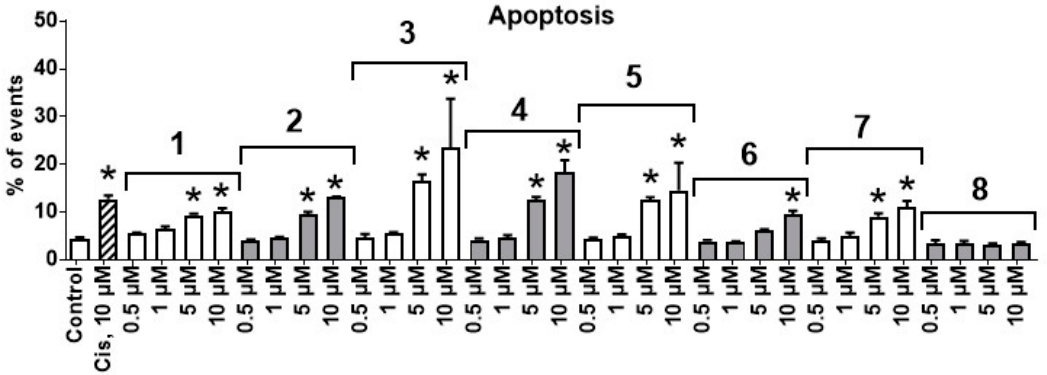
Figure 3. Effect of natural compounds on DNA fragmentation of PC-3 cells. Cells were treated with the investigated compounds for 24 h. The effects were analyzed by flow cytometry. Cells detected as sub-G1 population were considered to be apoptotic. Cisplatin (Cis) was used as a positive control. * p ≤ 0.05 (Student’s t-test).